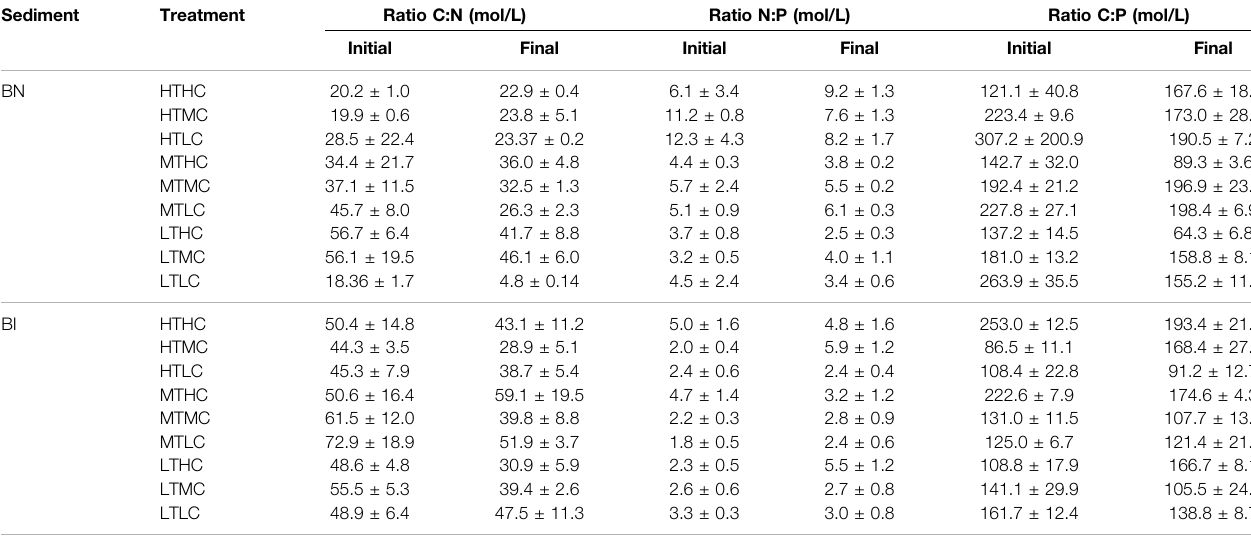
TABLE 7 | C:N, N:P and C:P ratios (in mol/L) by sediment type and treatment at the beginning and end of the experiments. Sediment